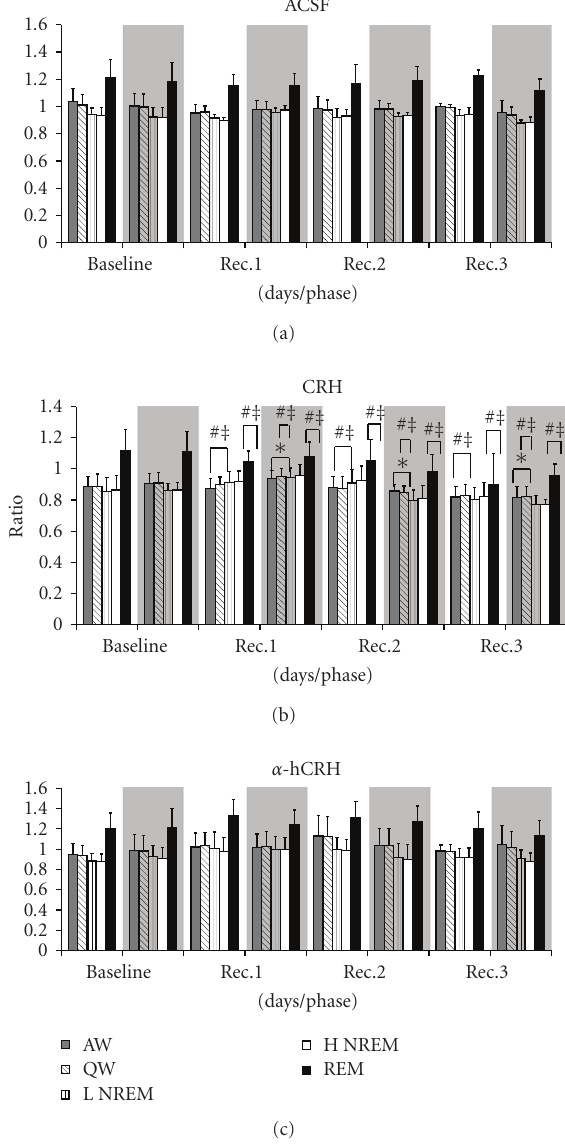
Figure 6: Theta/Delta . Theta/delta ratio is shown as mean of the total power in fast the θ (6.6–9.0 Hz) band divided by total power in fast δ (2.5–4.0 Hz) band, computed throughout ∼ 11 hours period in the light and dark phases of the recovery period. ACSF, artificial cerebrospinal fluid; CRH, corticotrophin-releasing hormone; α hCRH, alpha helical CRH 9 − 41 ; AW, active wake; QW, quiet wake; L NREM, low amplitude NREM sleep; H NREM, high amplitude NREM sleep; PS, REM sleep; Rec. Recovery period. The white panels indicate the light phase and the gray ones, the dark phase. ∗ - di ff erent from baseline, # - di ff erent from ACSF group, and ‡ - di ff erent from α hCRH group. Main e ff ects of sleep parameter are indicated by connecting lines above the bars. ANCOVA, followed by the Newman-Keuls test, P ≤ .